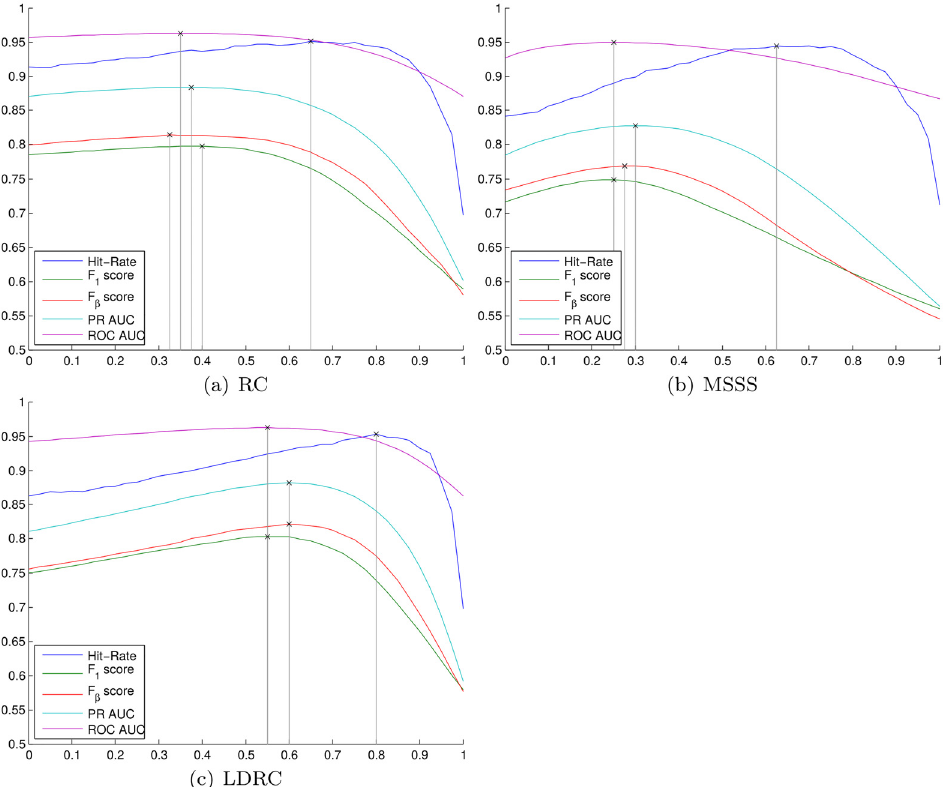
Fig 6. Illustration of the influence of the weight w C on the performance of RC+CB, LDRC+CB, and MSSS+CB (convex